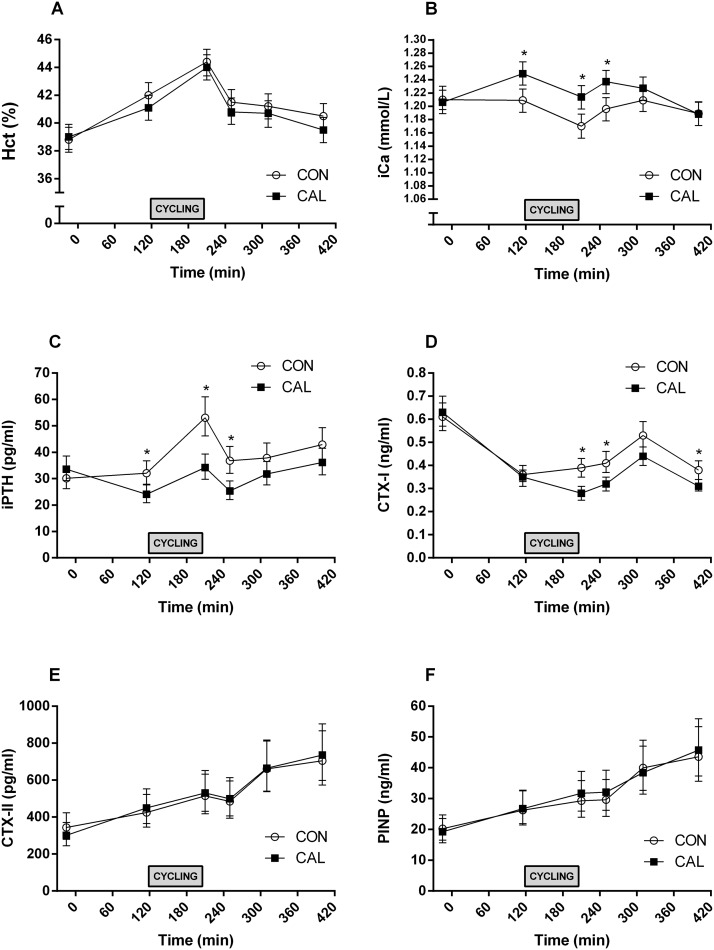
Serum concentrations of biomarkers for bone turn over, calcium homeostasis and haematocrit before and after control (CON) and calcium-rich (CAL) meal conditions and exercise.Mean ± 95% CI Haematocrit (Hct; A); ionized cacium (iCa: B); and concentrations of parathyroid hormone (PTH: C); cross linked C-telopeptide of type I collagen (CTX-I: D); cross linked C-telopeptide of type II collagen (CTX-II: E); procollagen I N-terminal propeptide (PINP: F); and at each time point for control (CON: open circles) and calcium (CAL: solid squares) trials. Blood samples were taken pre-trial at T = -15 min; pre-exercise at T = 115 min; and post-exercise at all subsequent time points. *Significant difference (p < 0.05) between trial meal conditions at the indicated time point